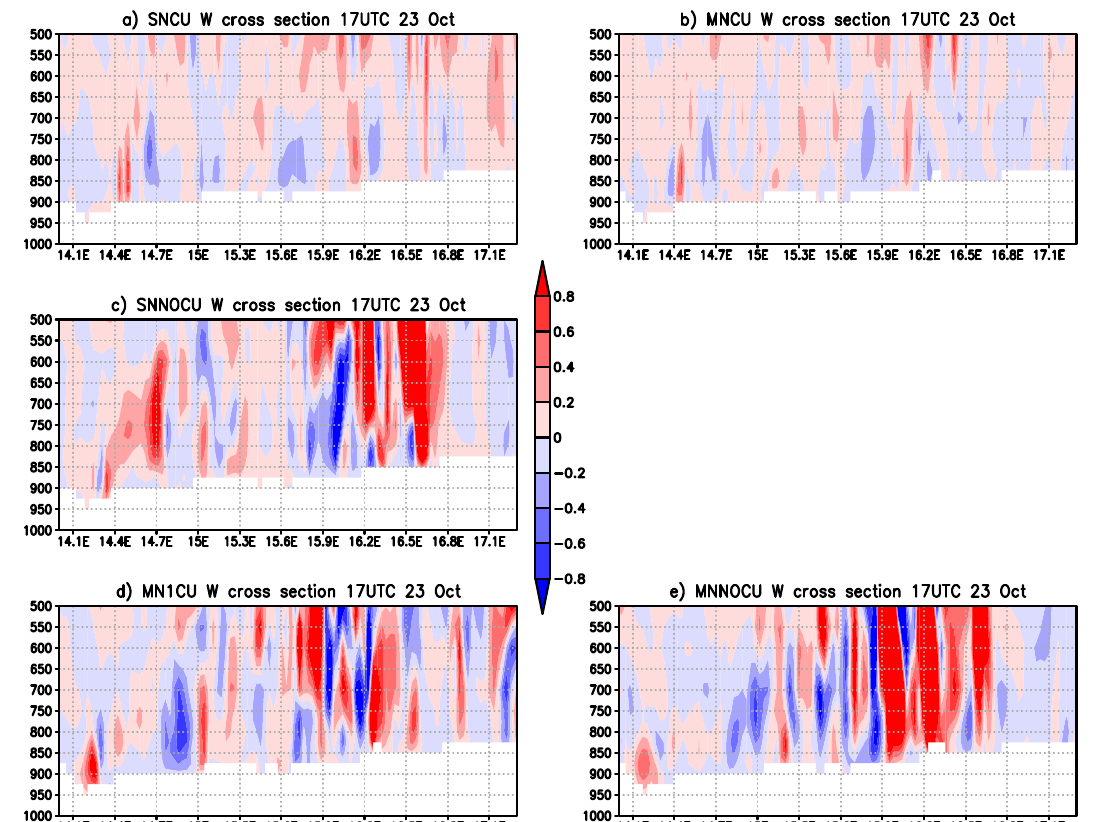
Figure 9. Shows the cross section of vertical velocity (m/s) with positive colors indicating updrafts, and blue colors indicating downdrafts for ( a ) SNCU, ( b ) MNCU, ( c ) SNNOCU, and ( d ) MN1CU and ( e ) MNNOCU for latitude 20.366 ◦ south and longitudes 14 ◦ to 17.3 ◦ east for 100hPa level to 500hPa. The white color indicates no data for below the surface.